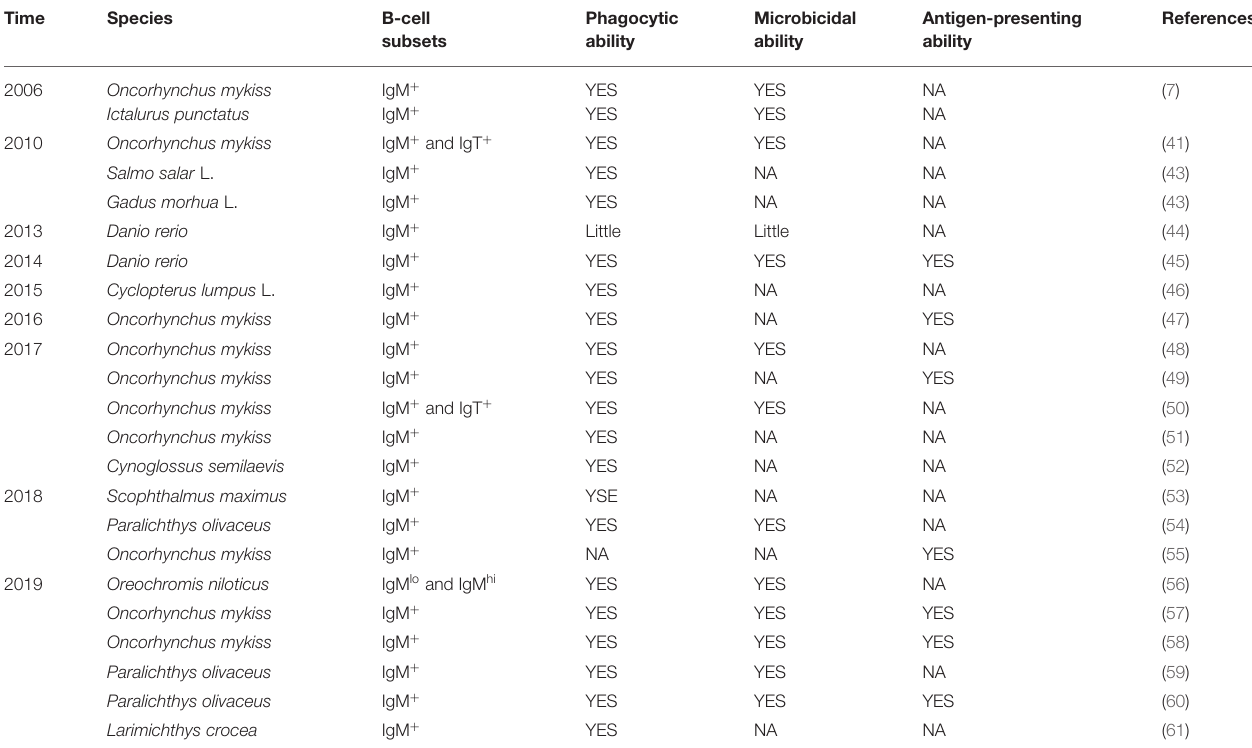
TABLE 1 | Studies of phagocytic B cells in teleost fish from 2006 until now. Time Species B-cell